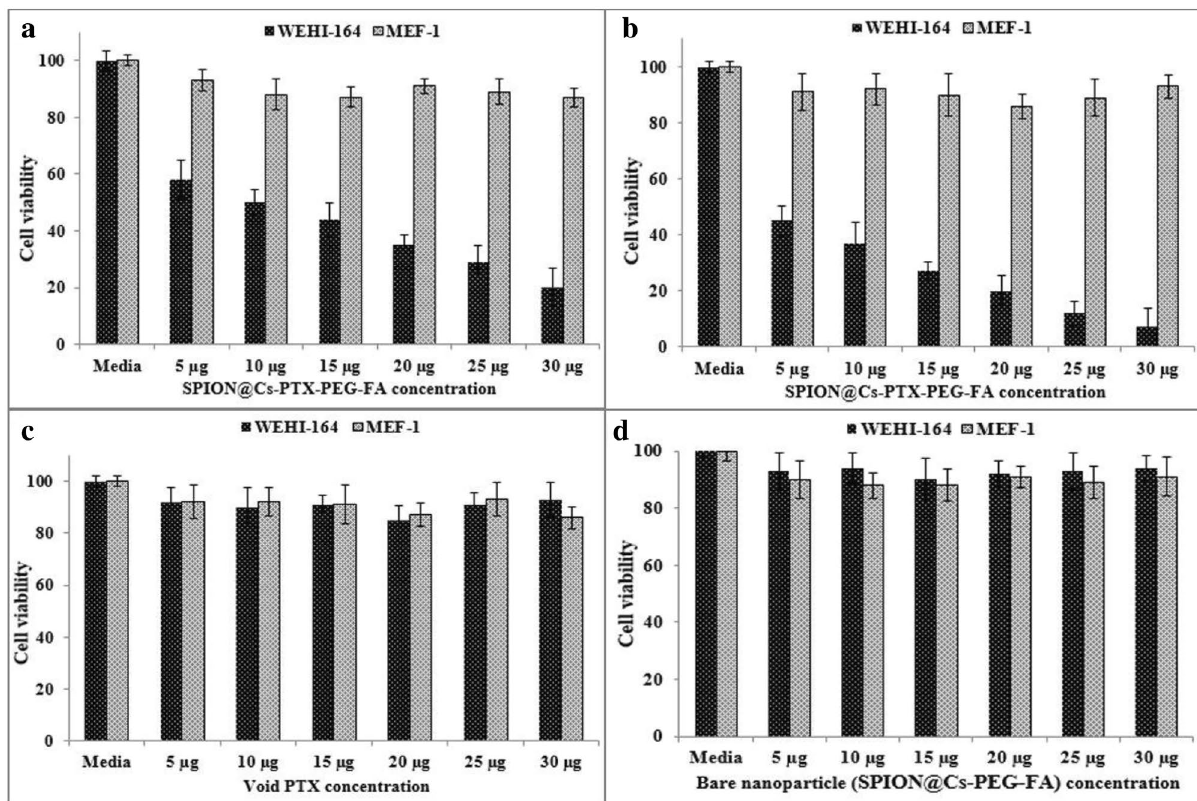
Figure 14. Cell-toxicity evaluation of SPION@Cs-PTX-PEG-FA nanoformulation by MTT assay on WEHI- 164 and MEF-1 cell lines with 24 h ( a ) and 48 h ( b ) incubation. The cells were also treated with void PTX ( c ) and bare SPION@Cs-PEG-FA NP ( d ) at the same concentration for 48 h (mean ± SD (*p < 0.05; **p < 0.01; ***p < 0.001); n =